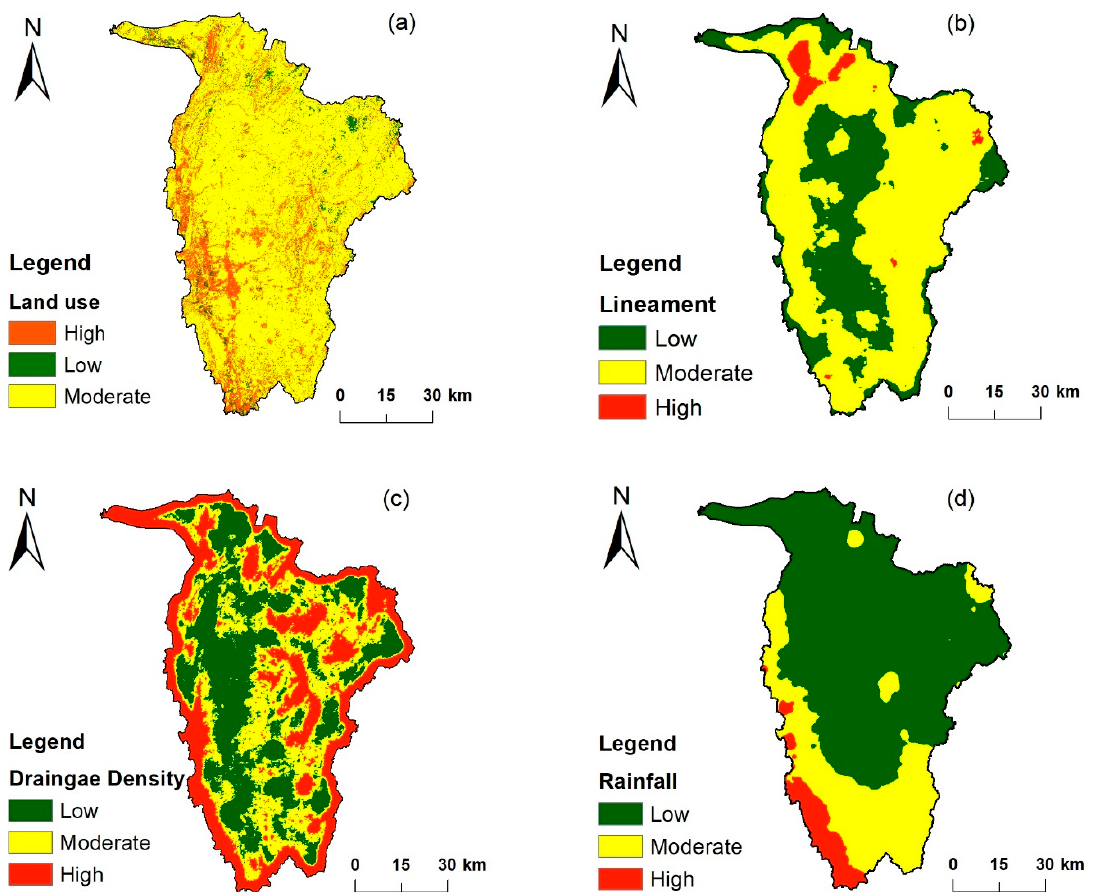
Figure 10. Reclassified thematic layers of (a) land use, (b) lineament density, (c) drainage density, and (d) rainfall.